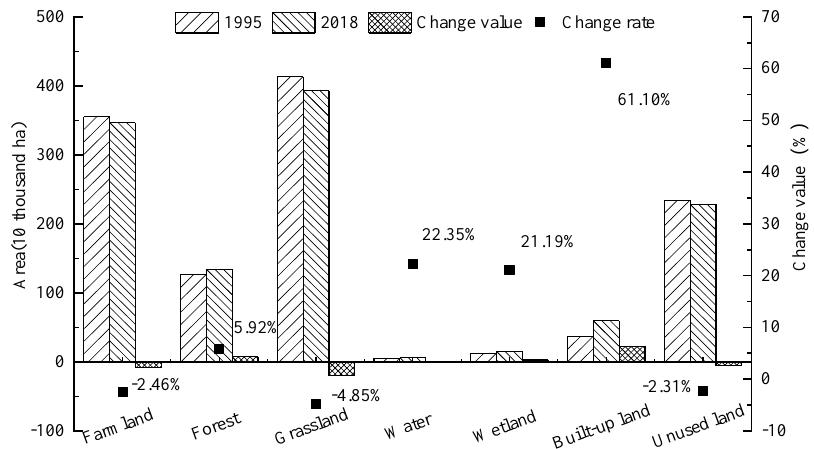
Figure 3. Urban land-use changes in the Yellow River Basin (China) in 1995 and 2018.